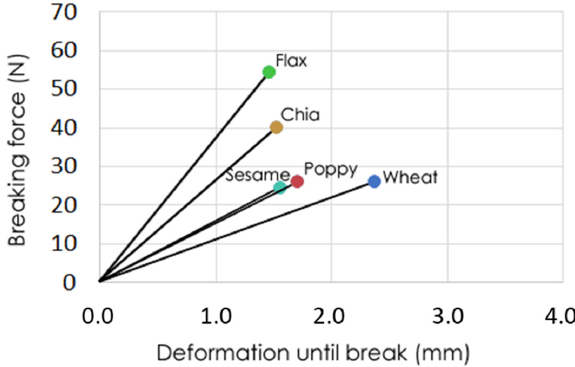
Figure 2. Maximum force and deformation until breaking for cookies elaborated with defatted seed flours. Points are the average value of five repetitions.